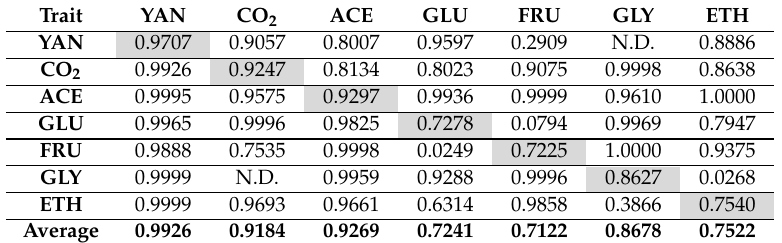
Table 1. Univariated (on the diagonal), bivariated (out of the diagonal) and average heritabilities (in bold) for the seven oenological traits evaluated. Trait YAN CO 2